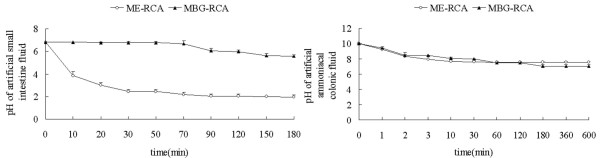
MBG-RCA significantly reduced the impact of the pH of artificial small intestinal fluid compared with ME-RCA and the influences of both on the pH of artificial ammoniacal colonic fluid